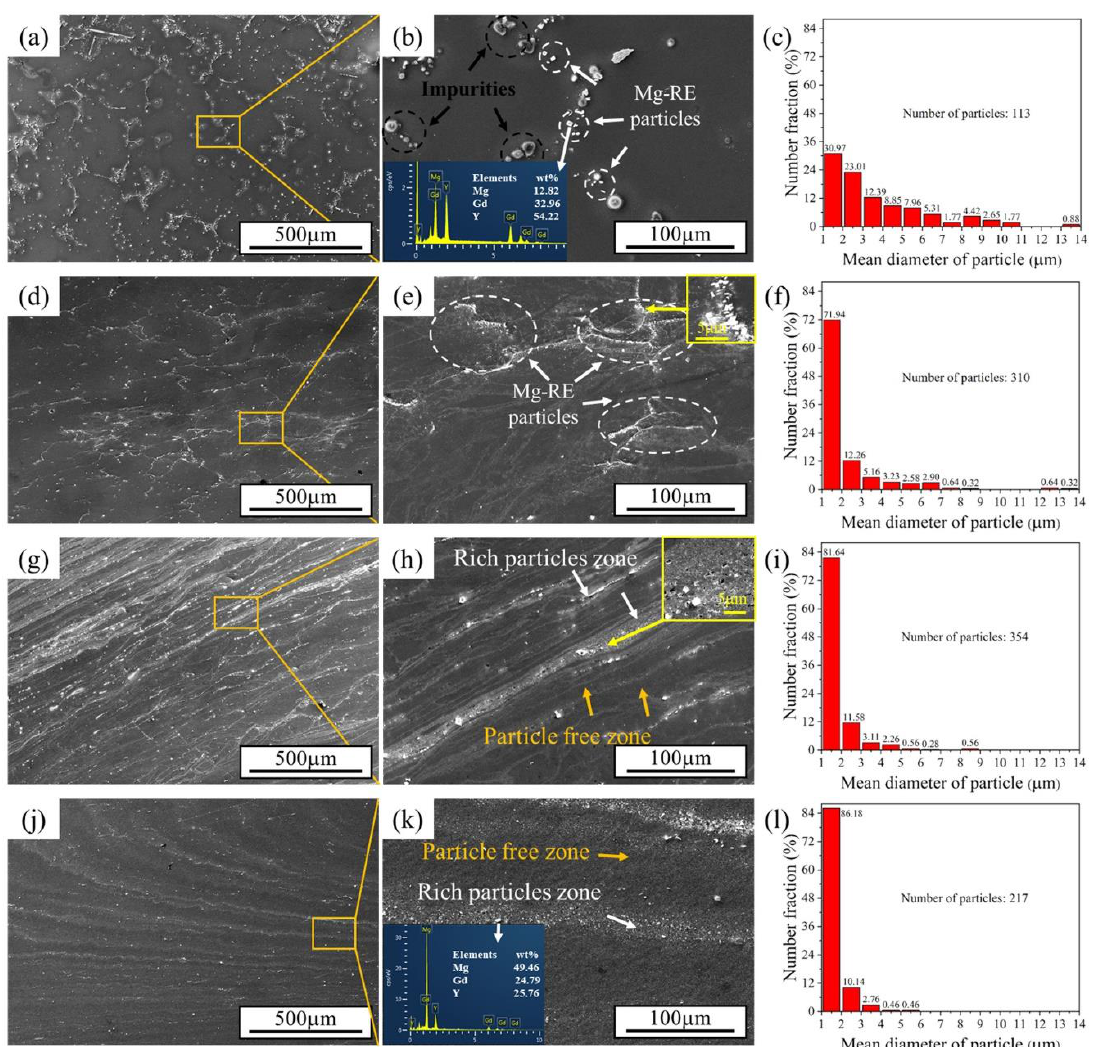
Figure 4. SEM morphologies in secondary electron signal (SE) of ( a , b ) homogenized, ( d , e ) 1P, ( g , h ) 4P, and ( j , k ) 12P samples; ( c , f , i , l ) the mean diameter distribution of particles (d > 1 μ m) in maps ( b , e , h , k ).